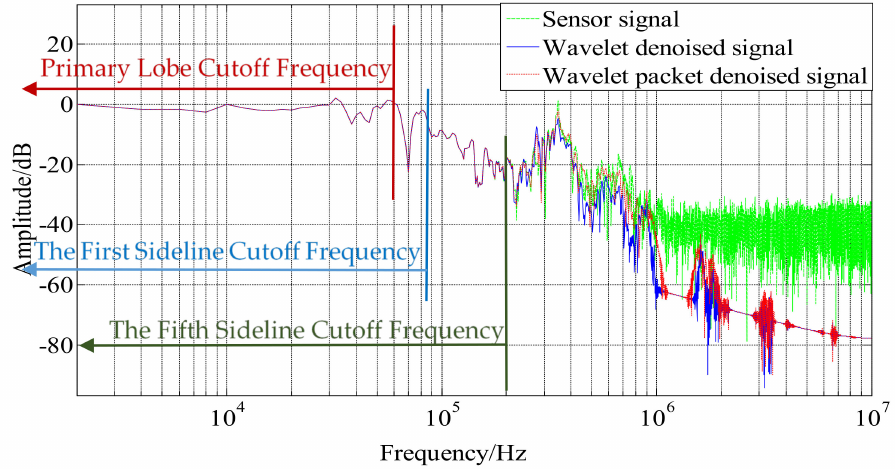
Figure 16. Normalized amplitude-frequency curve before and after